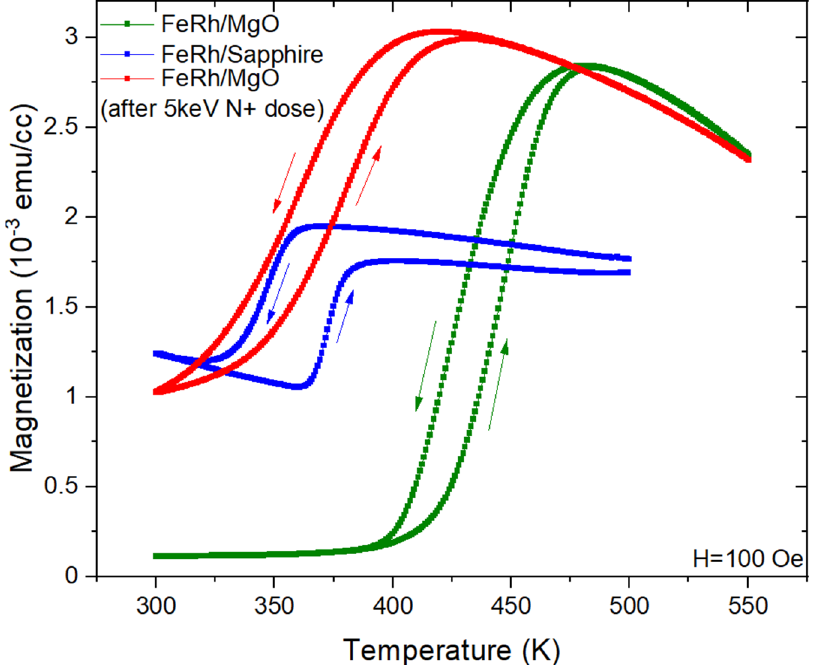
Figure 2. SQUID magnetometry data of the three samples (FeRh on sapphire (blue), FeRh on MgO (green), FeRh on MgO with a 5kV N + dose (red). Arrows indicate sweep direction of temperature with all measurements starting at 300 K.